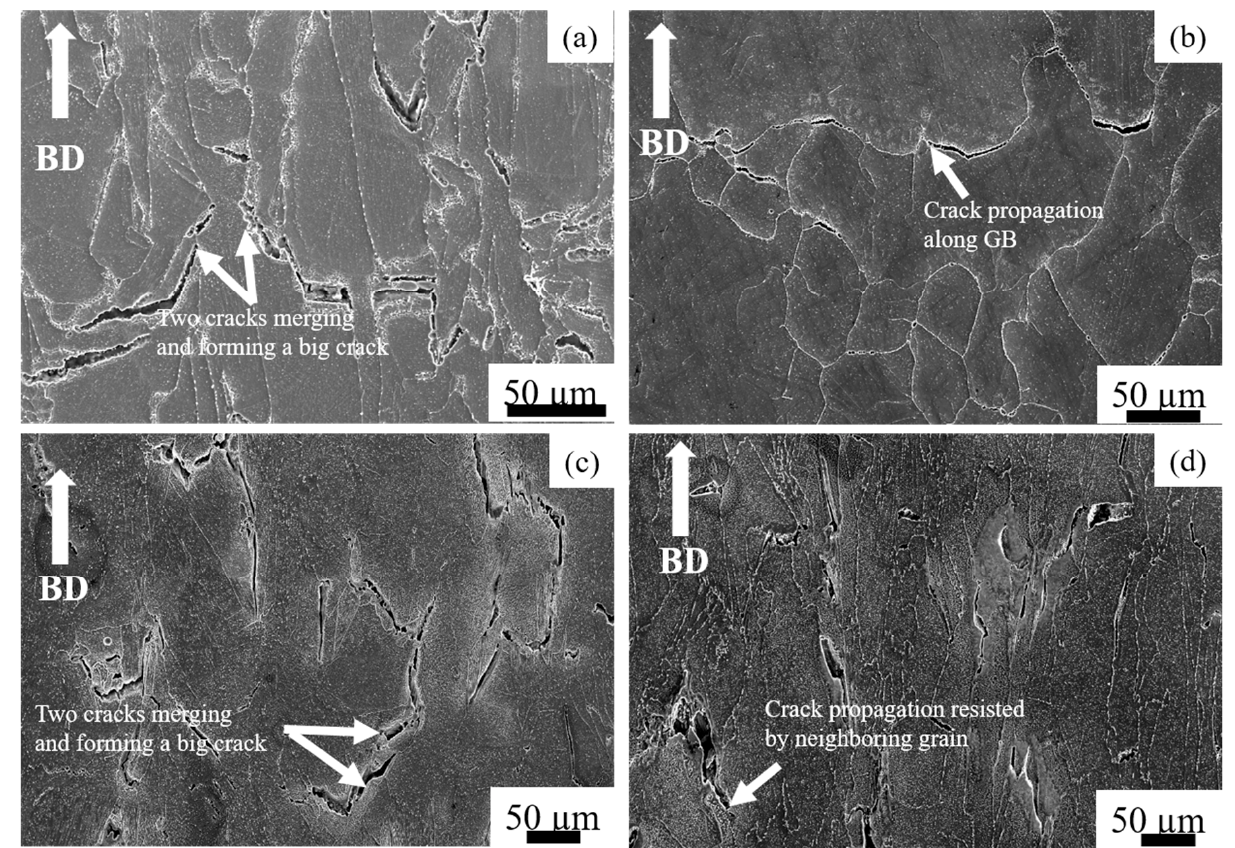
Figure 12. Microstructures in the vertical specimens after creep test ( a ) as-built HX, ( b ) HX ST, ( c ) as-built HX-a, and ( d ) HX-a ST.